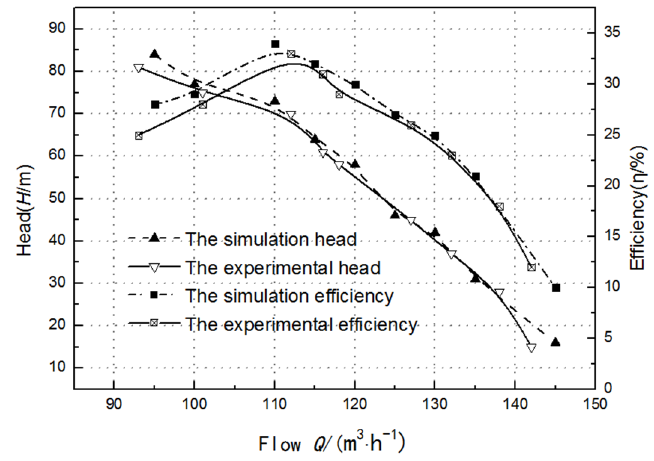
Figure 6. Comparison of the experimental and numerical results.